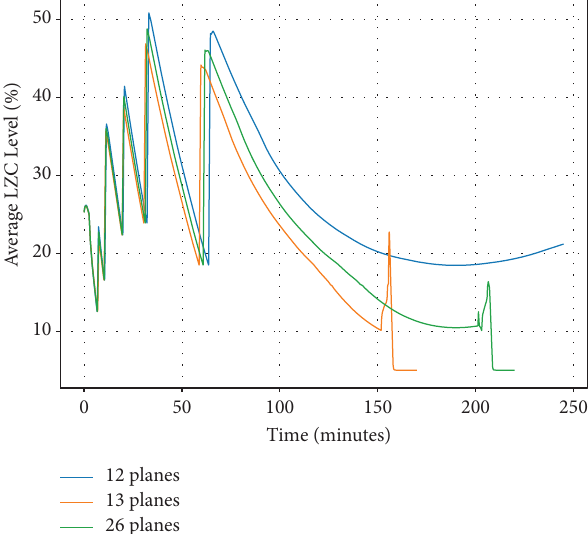
Figure 9: Efect of core nodalisation–59% FP